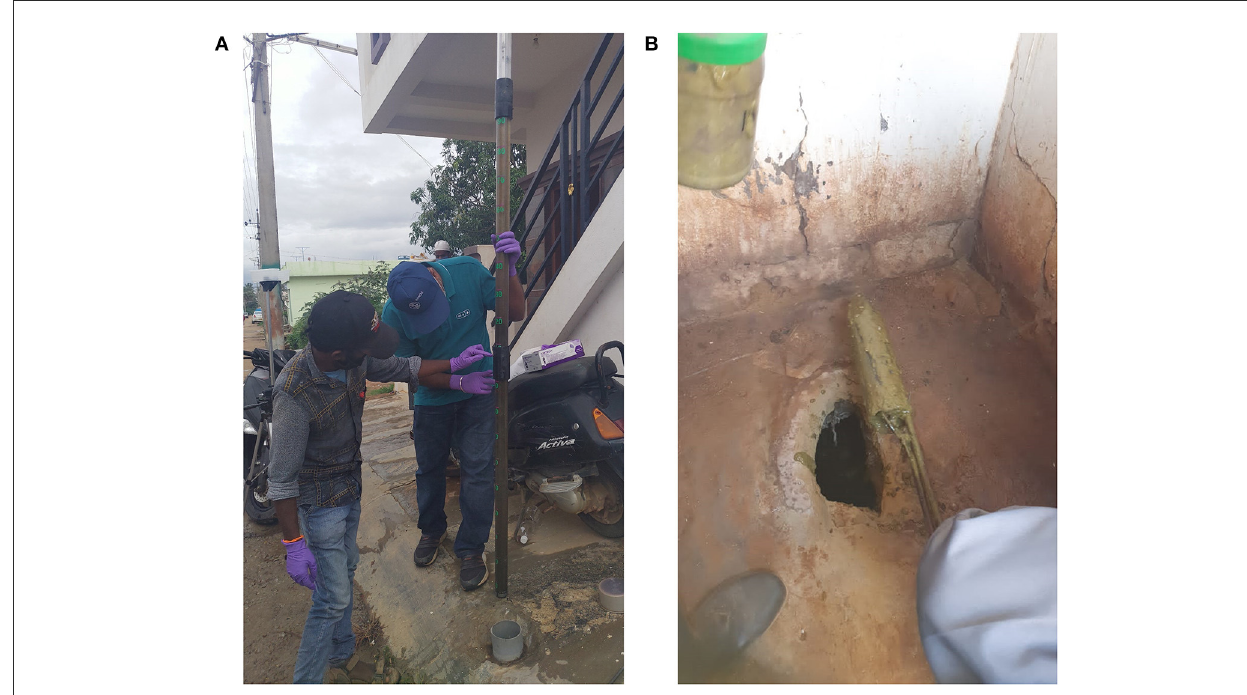
FIGURE2 (A) Example of a core sampler, used in India. (B) Example of a pit sampler, used in